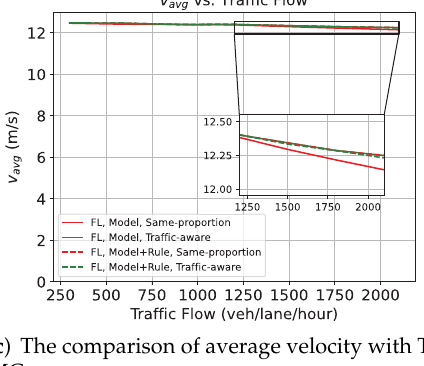
Figure 7. The comparison of average velocity v avg .